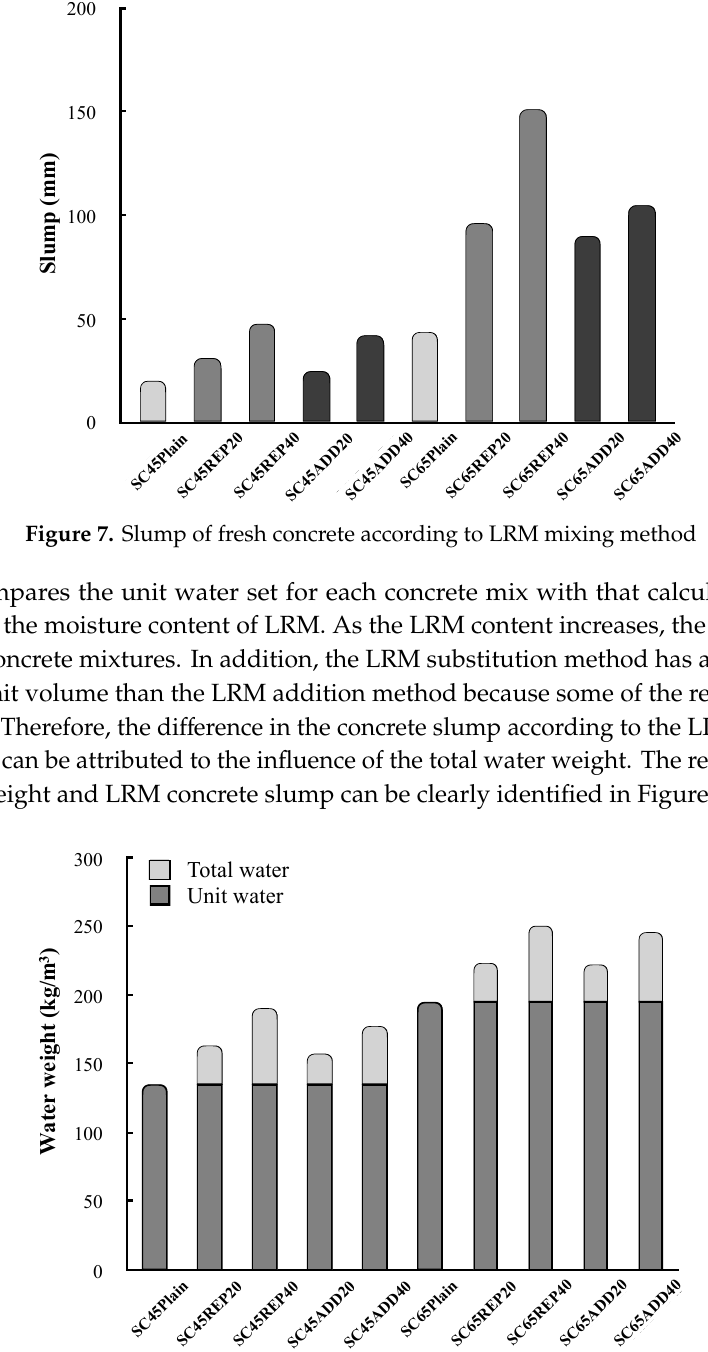
Figure 8. Water weight in mix proportion according to LRM mixing method